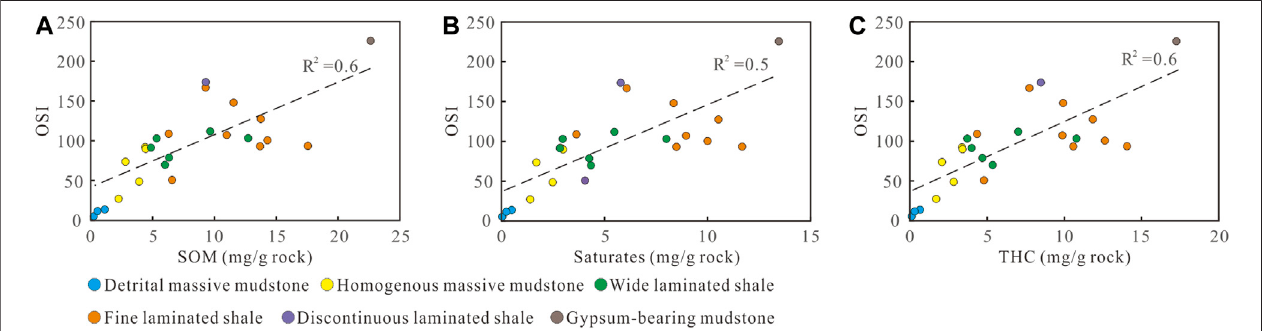
FIGURE 10 | Correlations between OSI and the contents of SOM, saturates and THC content.